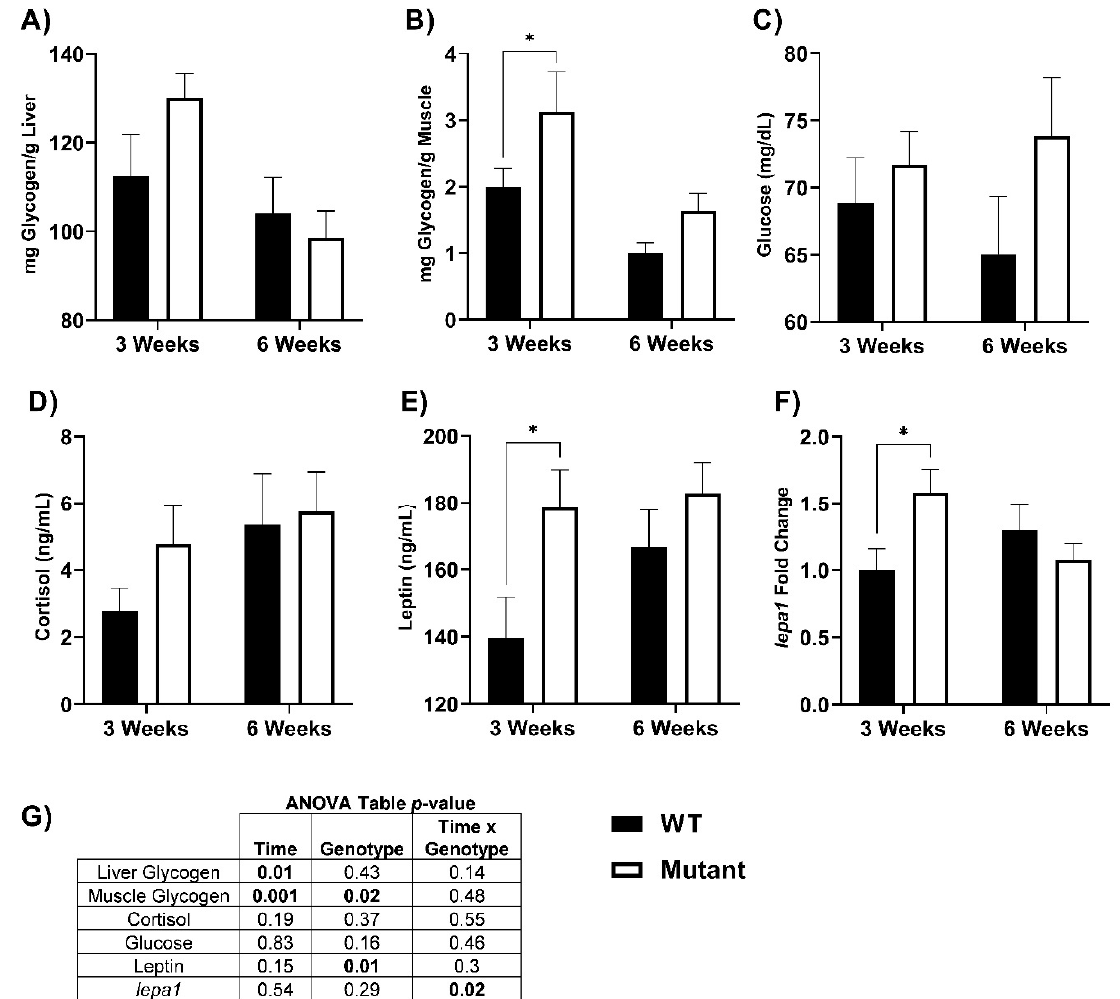
Figure 4. Liver and muscle glycogen, cortisol, and leptin measurements in WT and LepR mutant rainbow trout that were fed to satiation for six weeks. ( A ) liver glycogen (mg/g liver), ( B ) muscle glycogen (mg/g muscle), ( C ) blood glucose (mg/dL), ( D ) plasma cortisol (ng/mL), ( E ) plasma leptin (ng/mL), ( F ) hepatic lepa1 mRNA expression (fold-change from three-week WT), ( G ) ANOVA table. Values reported as means ± SEM. * denotes significant differences between WT and mutant fed fish within each time point. (* p ≤ 0.03, n = 8–15). The significant p -values from different interactions are shown bolded in the ANOVA table in panel 4G.